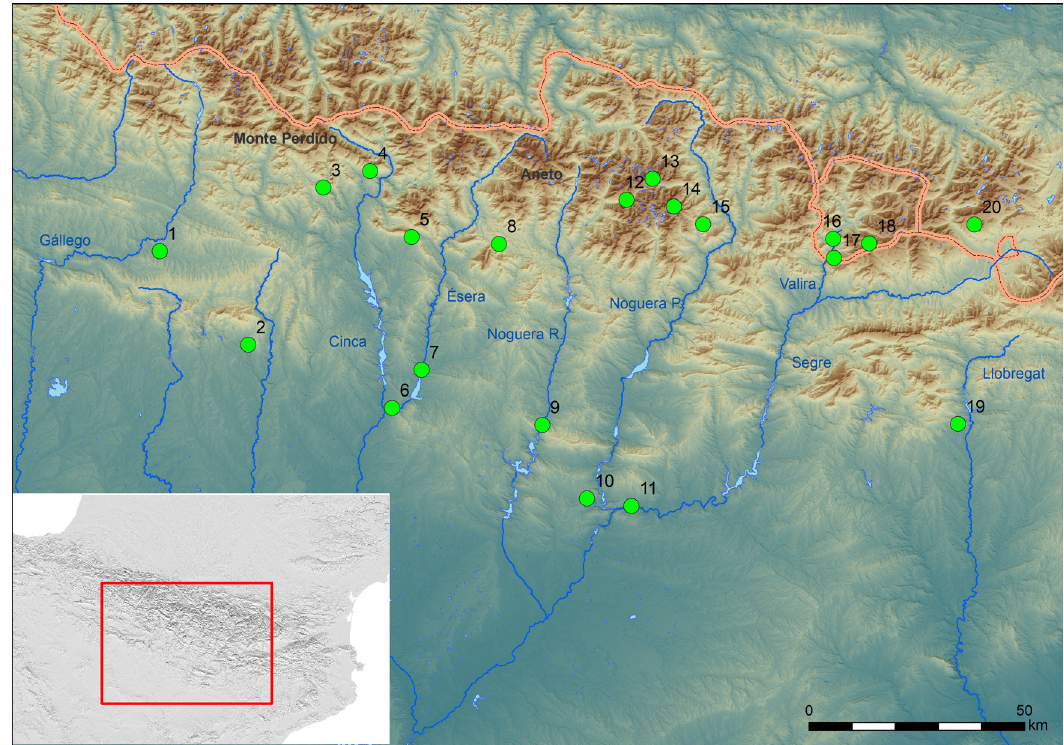
Figure 1: Geographical framework and sites cited in the text. ( 1 ) Abrigo de l ’ Esplugón; ( 2 ) Cueva de Chaves; ( 3 ) Cueva Lóbrica; ( 4 ) Coro Trasito; ( 5 ) La Puyascada; ( 6 ) Cueva del Moro de Olvena; ( 7 ) Abrigo de las Forcas II; ( 8 ) Els Trocs; ( 9 ) Cova Colomera; ( 10 ) Cova Gran; ( 11 ) Cova del Parco; ( 12 ) Cova del Sardo; ( 13 ) Obagues de Ratera; ( 14 ) Abric de l ’ Estany de la Coveta I;